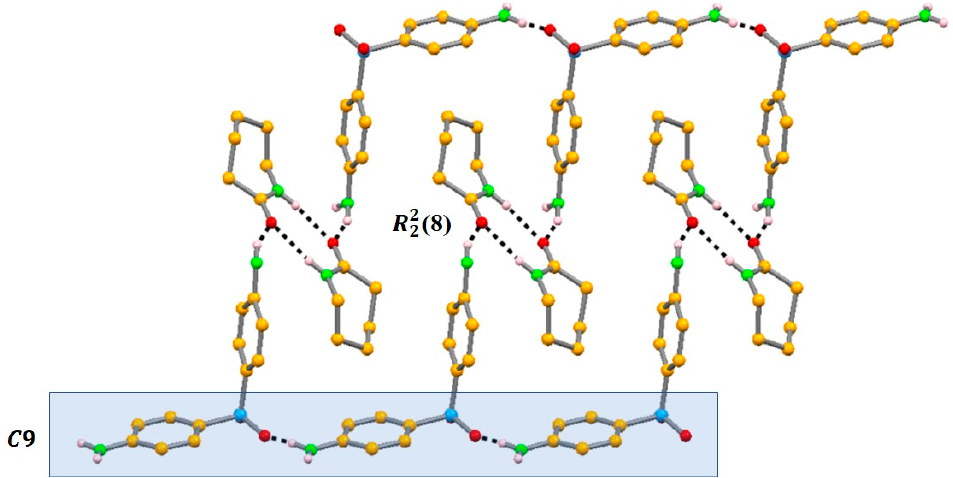
Figure 6. Crystalline packing of DAP:CAPRO: view along c showing the R 2 2 (8) formed between CAPRO molecules and the capping by DAP molecules, supporting the chain of DAP molecules along a [49].